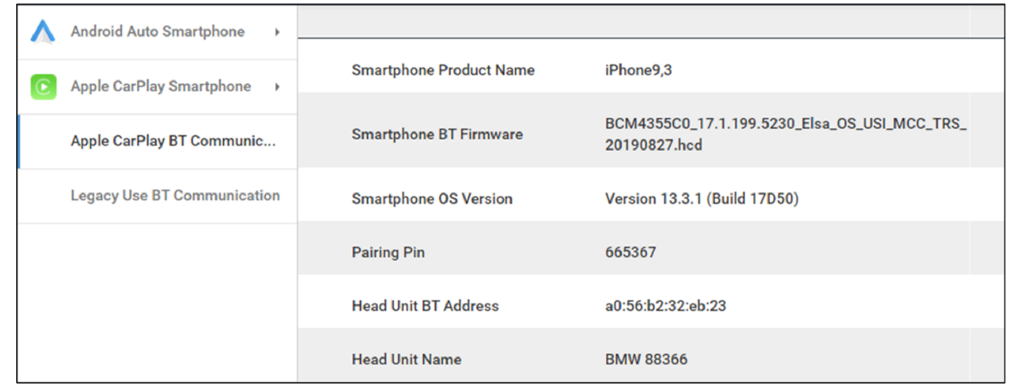
Figure 11. Results of analyzing the BT packet between the mobile device and vehicle.